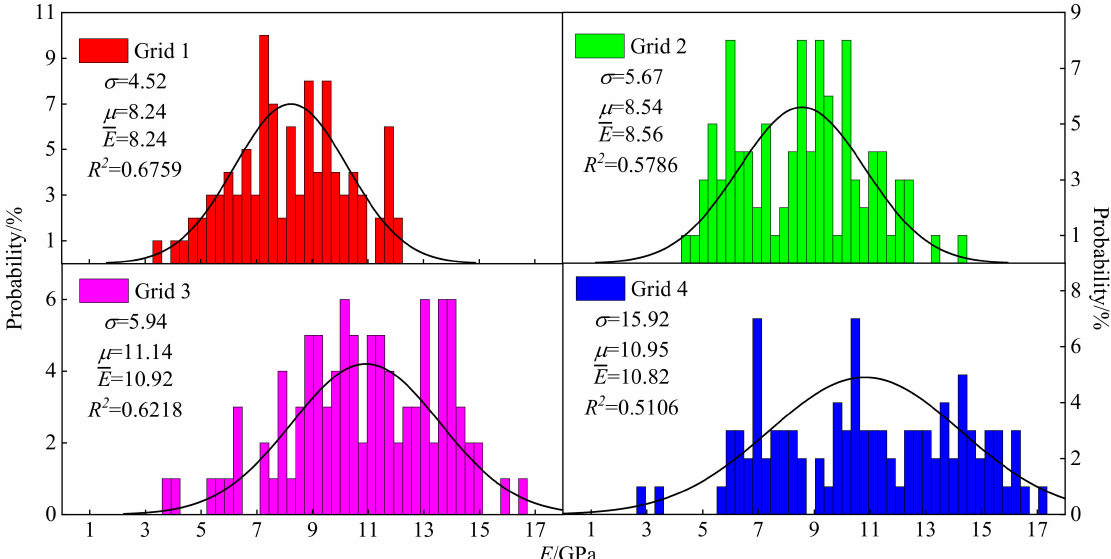
Figure 7. Frequency distribution histogram of elastic modulus. The closer the value of R 2 is to 1, the better the fit of the regression line to the observed values; on the contrary, the smaller the value of R 2 , the worse the fit of the regression line to the observed